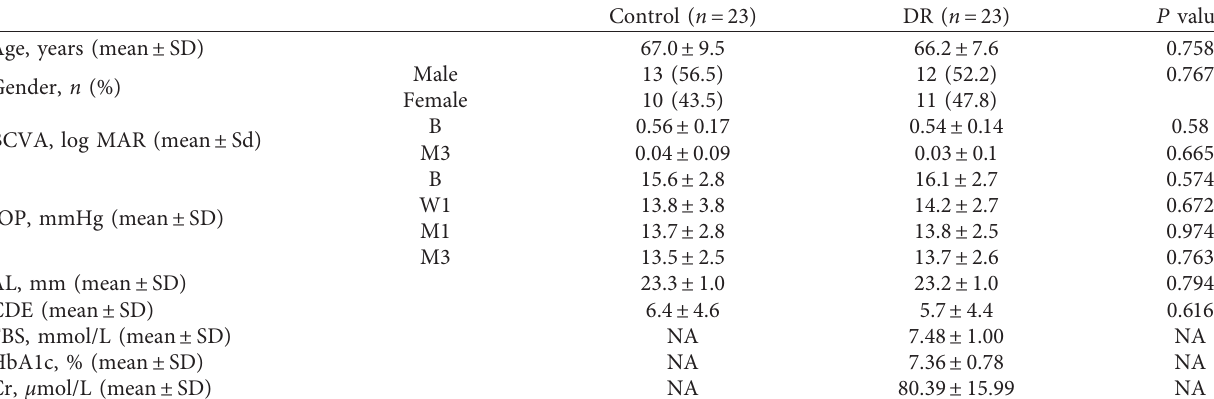
Table 1: Demographic and clinical characteristics of the eyes included for